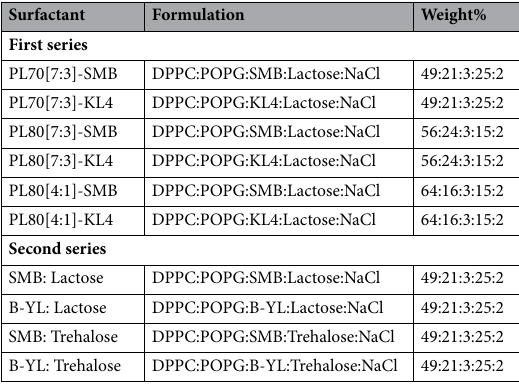
Surfactant Formulation Weight% First